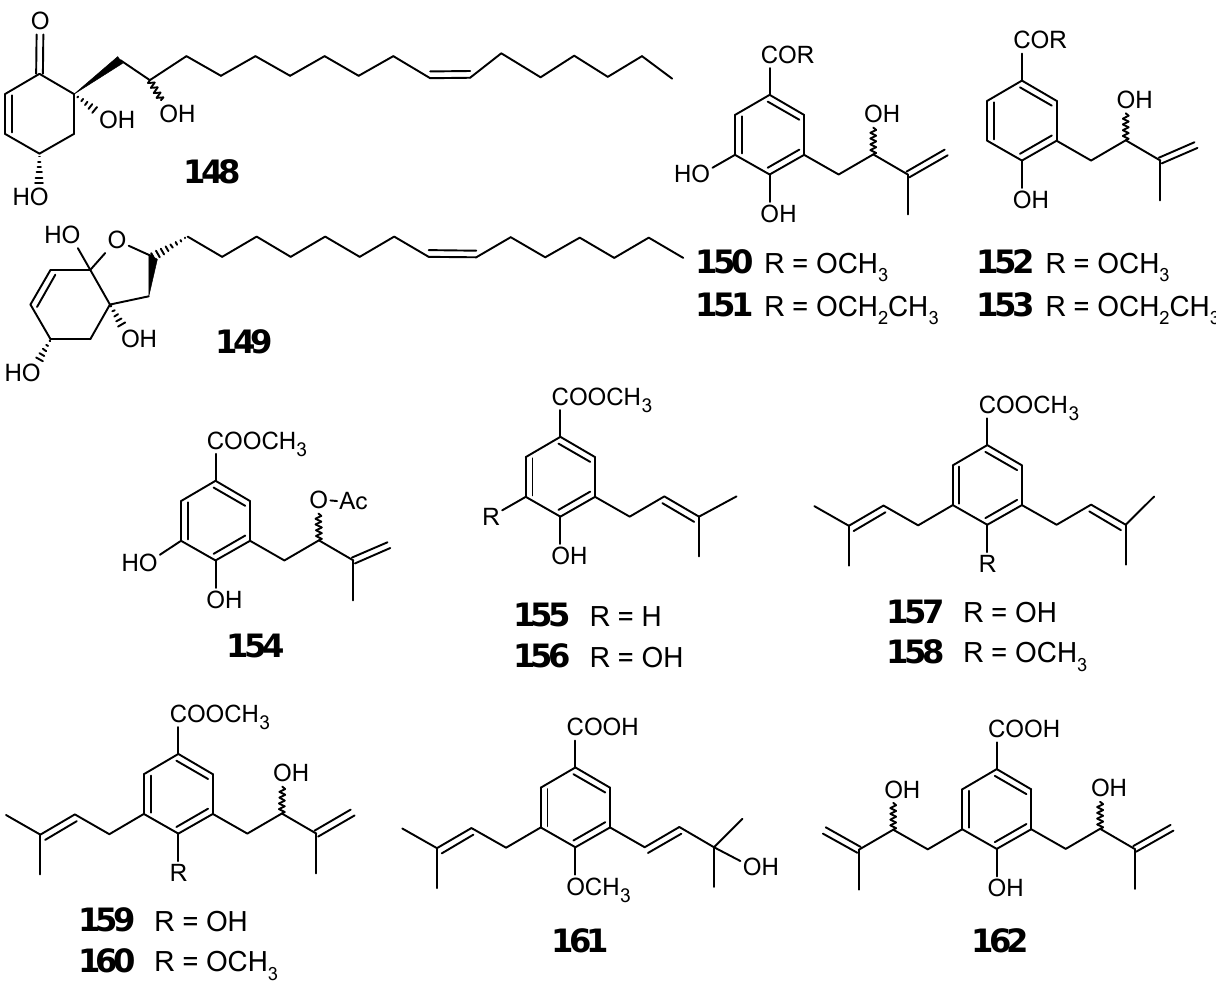
Figure 16. Antiplasmodial miscellaneous compounds 148-162